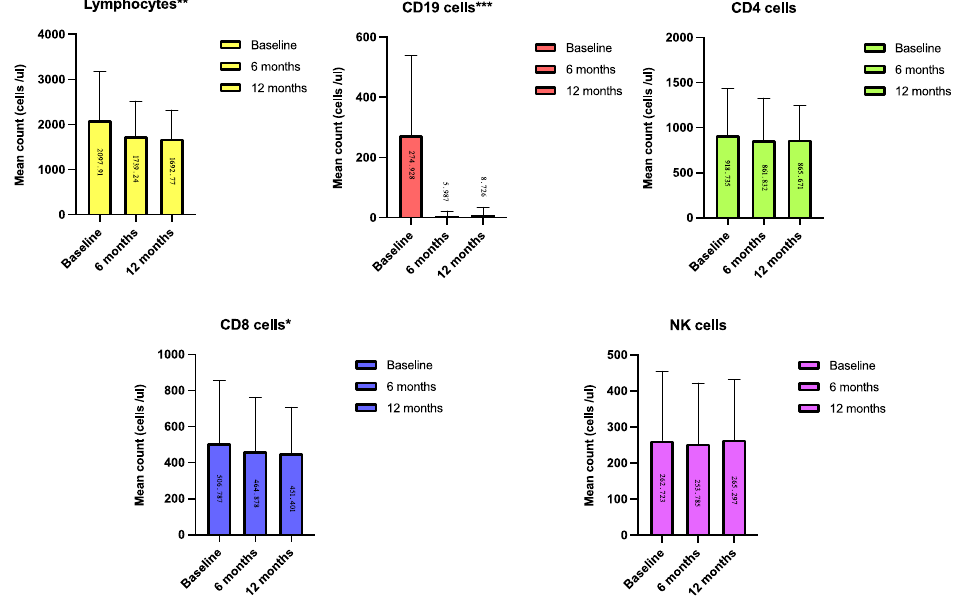
Figure 2. Absolute lymphocyte and lymphocyte subset counts at baseline, after six and twelve months of Ocrelizumab treatment (mean counts). For all the immune cells, 155 patients had a twelve-month follow-up and were included in the analysis of variance for multiple comparison; a significant reduction in mean absolute number of lymphocytes, CD8 T cells and CD19 cells was revealed. * p < 0.05; ** p < 0.01; *** p < 0.001.